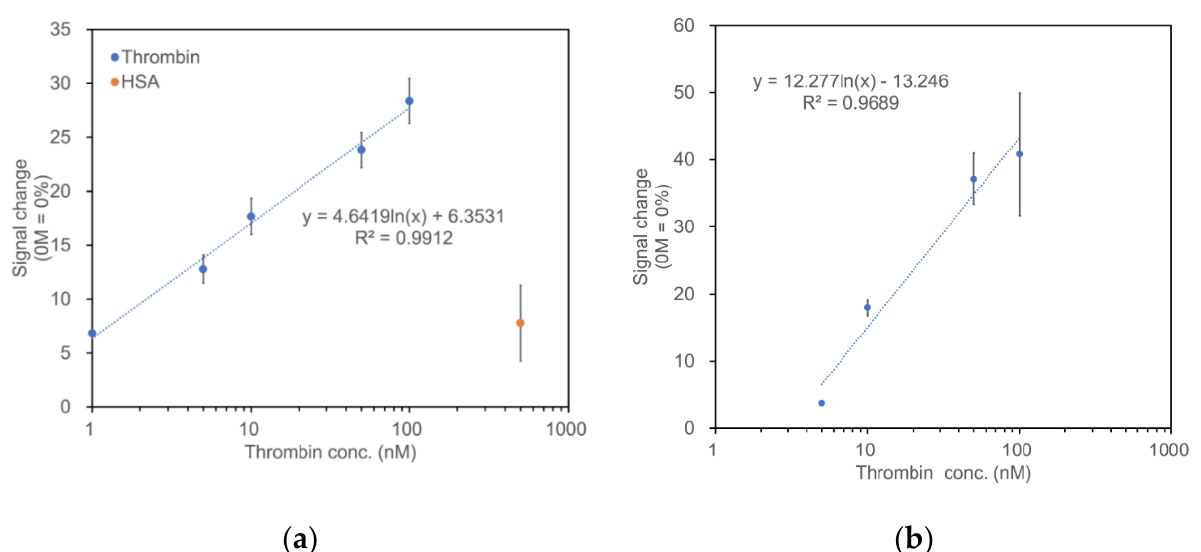
Figure 3. Thrombin concentration-dependent signal change (%) at PES-modified TBA immobilized electrodes ( a ) and at MB-modified TBA immobilized electrodes ( b ). Calculated as 0 M = 0%. Error bars indicate standard deviations ( n = 3).